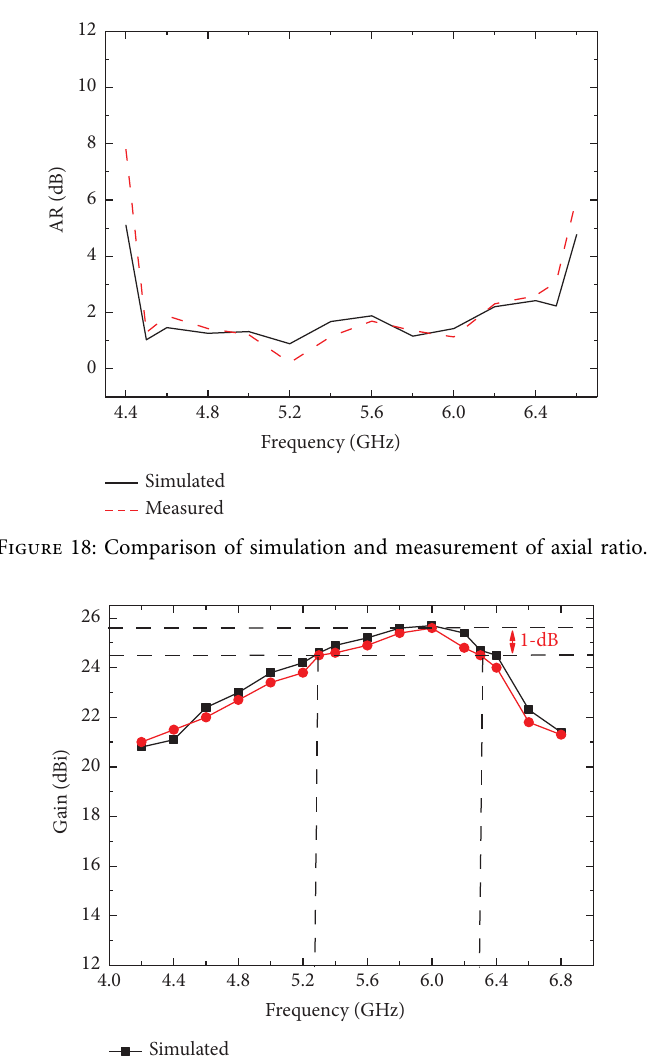
Figure 17: Te normalized gain pattern of the refectarray antenna at (a) 4.5GHz, (b) 5.8GHz, and (c) 6.5GHz.